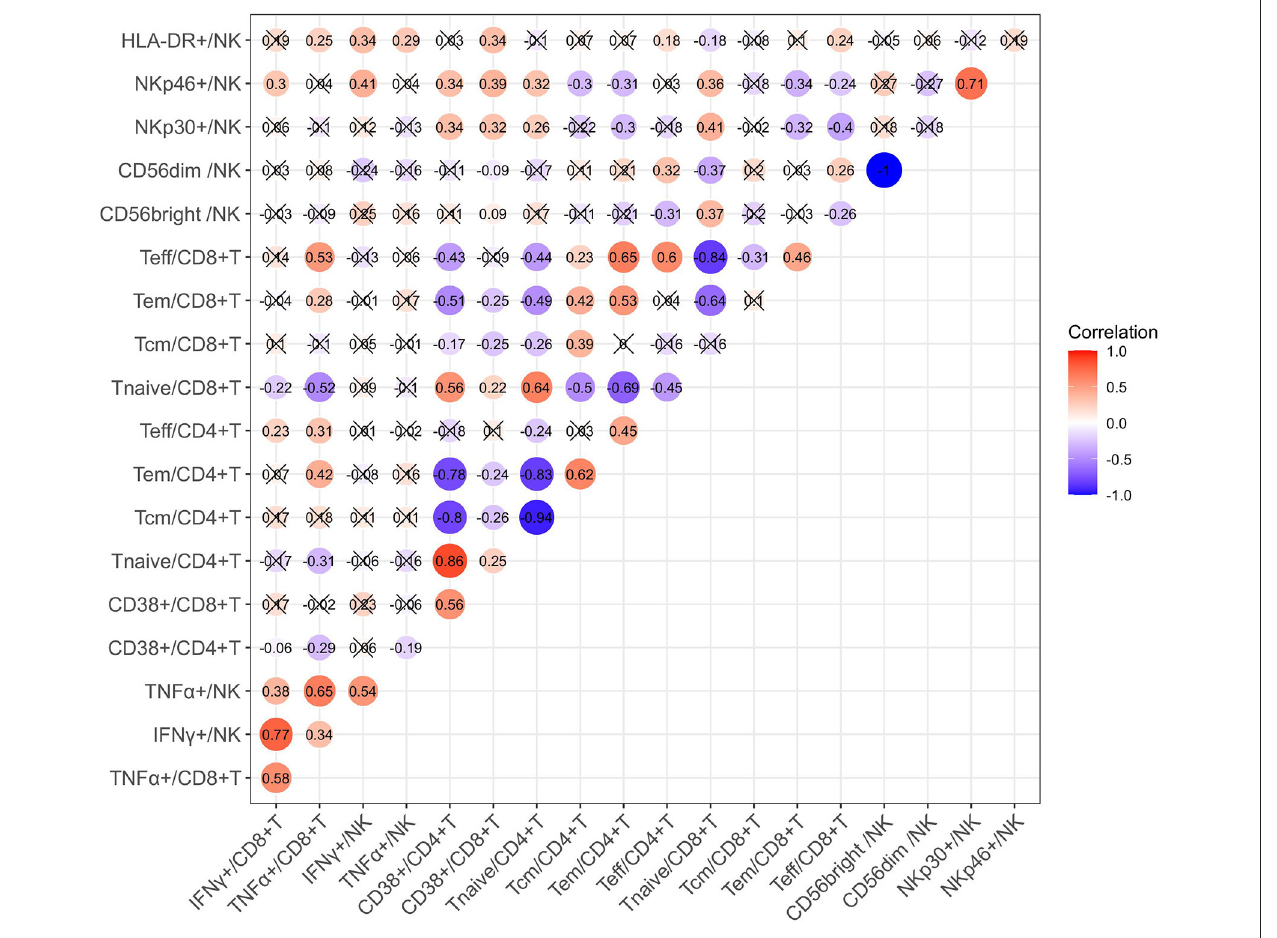
FIGURE 6 | Correlation matrix of different immune cell phenotypes.